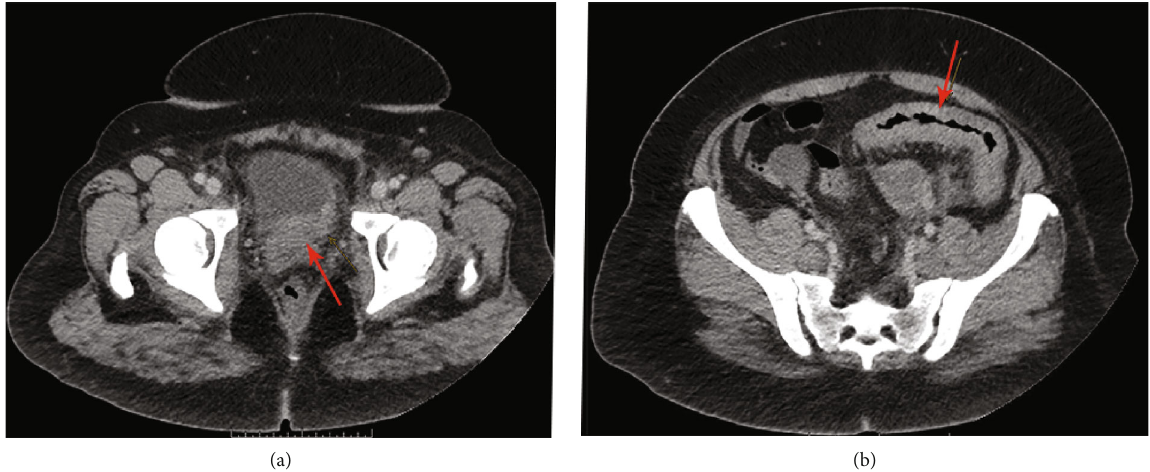
Figure 1: Axial abdominal computed tomography (CT): urinary bladder with thickening of the left posterior wall (a); midportion of sigmoid colon with wall thickening and pericolic in fi ltration suggestive of acute-subacute segmental colitis